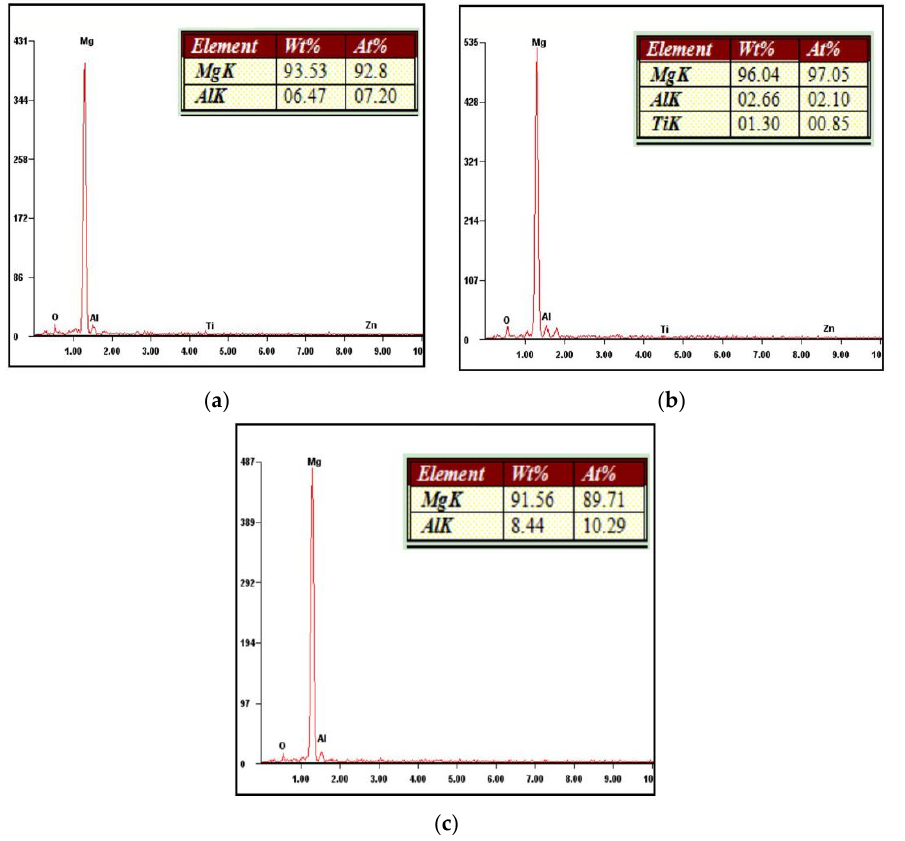
Figure 4. Elemental energy spectrum analysis of three points A, B, C. ( a ) Site A; ( b ) Site B; ( c ) Site C